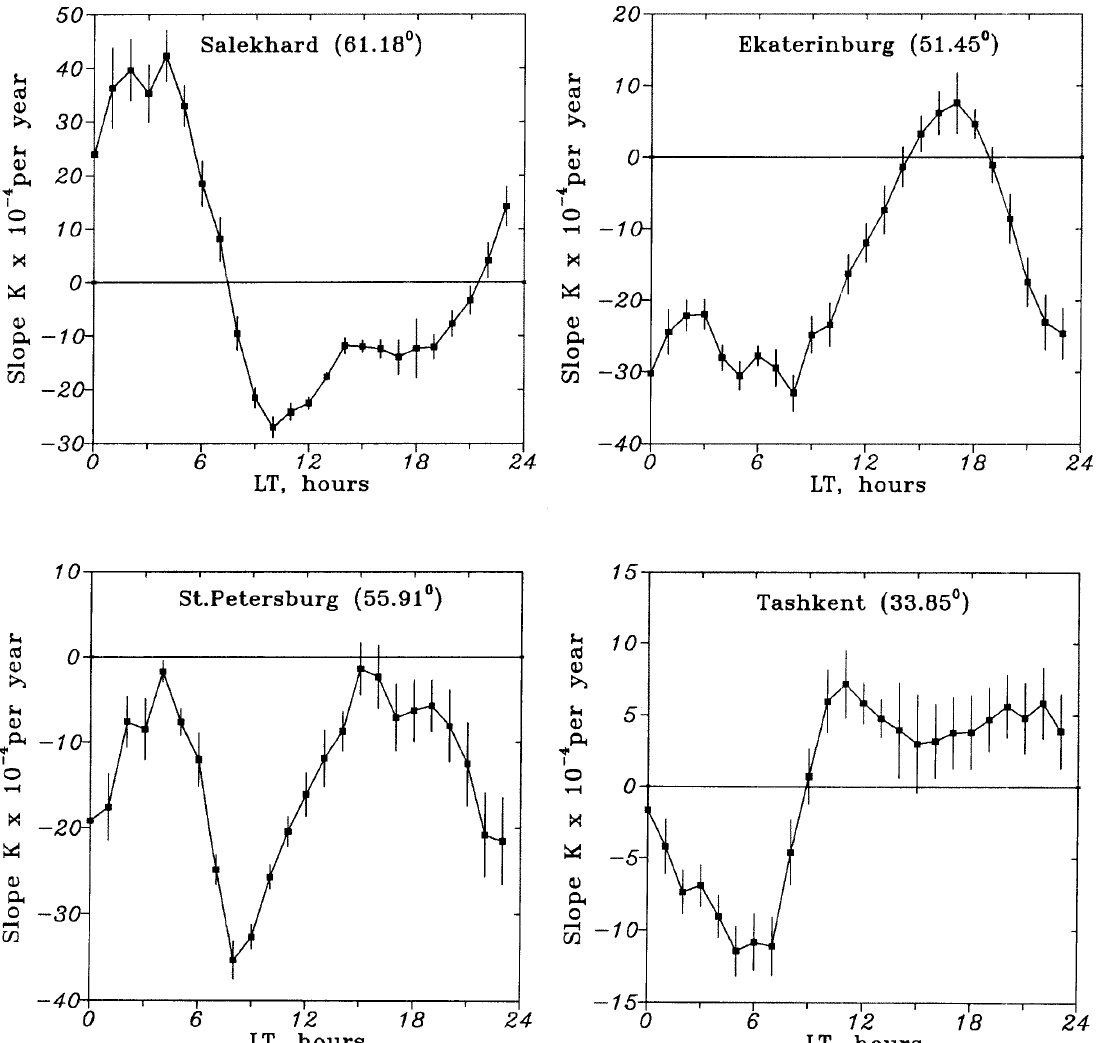
Fig. 6. Diurnal variation of annual mean slope K for stations located at di(cid:128)erent invariant latitudes (given in brackets ). Note strong and opposite types of diurnal variations for sub-auroral and midlatitude